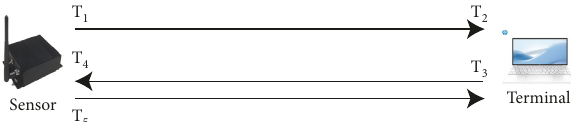
Figure 2: A timestamp exchange between a sensor and the